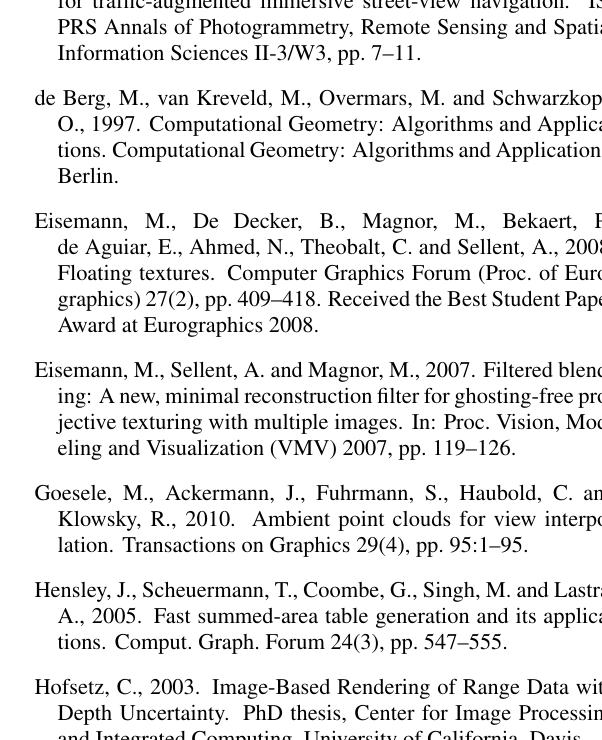
Figure 10: Silhouette-aware filtered blending. (Left) presents a failure case where the uncertain volume is underestimated. The protruding element is not part of the 3D model, which leads to a hard edge in the depth-uncertainty only rendering (top). The proposed approach (bottom) handles the bluring of the pixels up to silhouette of the near surfaces, resulting in a discontinuity artefact. (Right) presents a blending of the 3 nearest views with (top) depth-only uncertainty (+-1m) and with (bottom) silhouette-aware uncertainty (with the cubic structuring element [ − 1 , 1] 3 ). Both views show similar results like the ghosting of mobile objects (pedestrians). The amount of blur in (bottom) is fully 3D and thus takes the surface normal angle into account, which produces more blur on the surfaces that are not front facing(e.g. the ground). The main difference is on the handling of occlusion boundaries (edge of the left building) which trades out the doubling artefact for a blur. algorithm for uncertain geometry under the specific uniform pro- jection